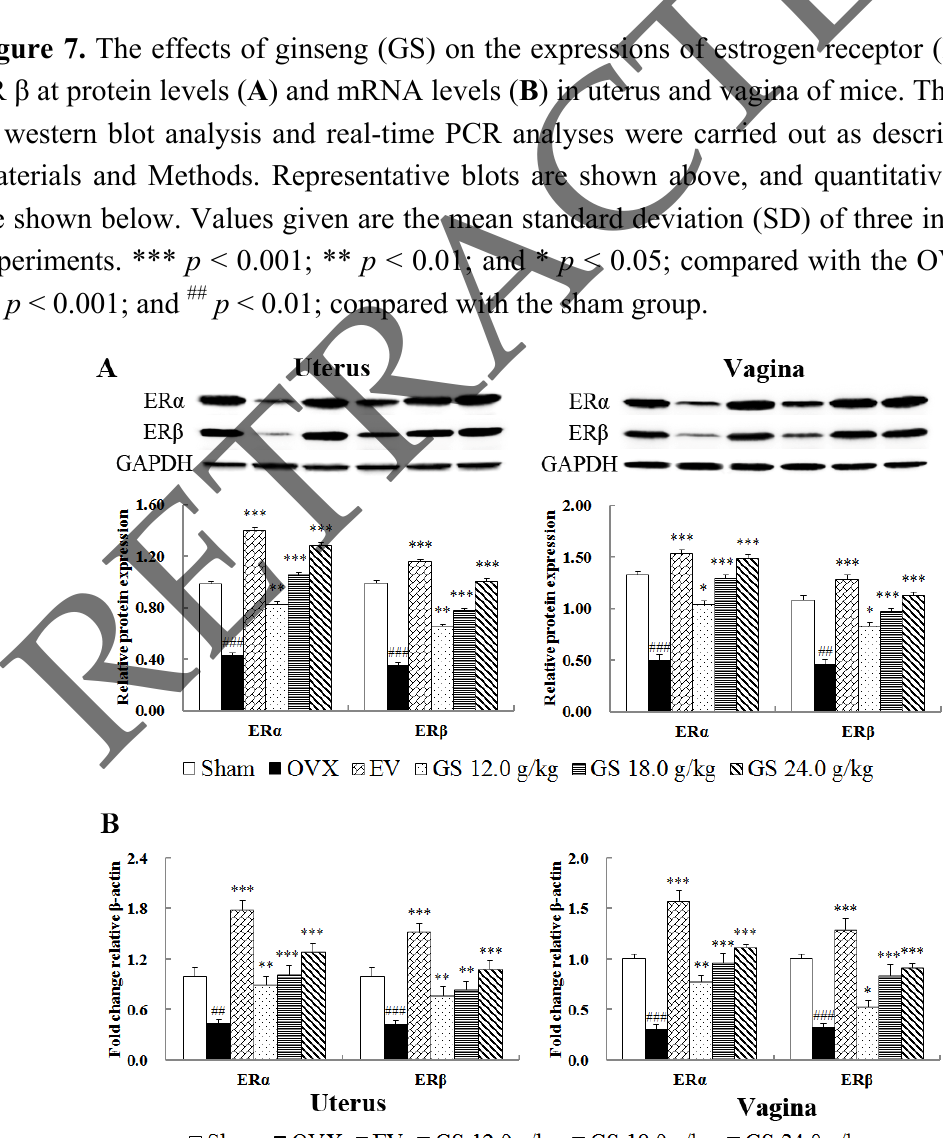
Figure 7. The effects of ginseng (GS) on the expressions of estrogen receptor (ER) α and ER β at protein levels ( A ) and mRNA levels ( B ) in uterus and vagina of mice. The methods